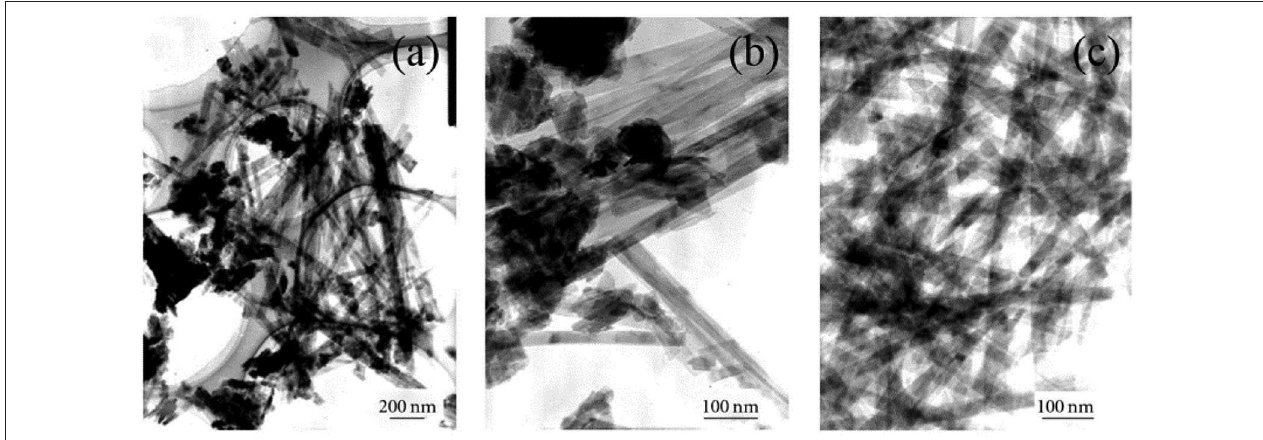
FIGURE 6 | TEM images for Ni/Al LDHs synthesized at different pH values. (a) 5.5, (b) 8.5, (c) 10.0 (Zhao et al.,